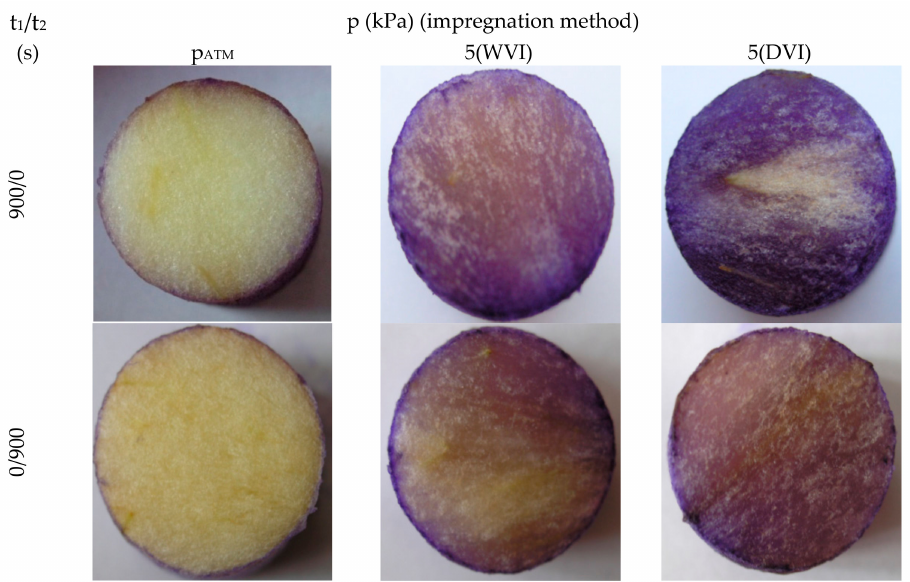
Figure 8. Apple tissue impregnated in di ff erent conditions using a staining solution with a viscosity coe ffi cient η = 1 mPa · s for the selected values of parameters t 1 and t 2